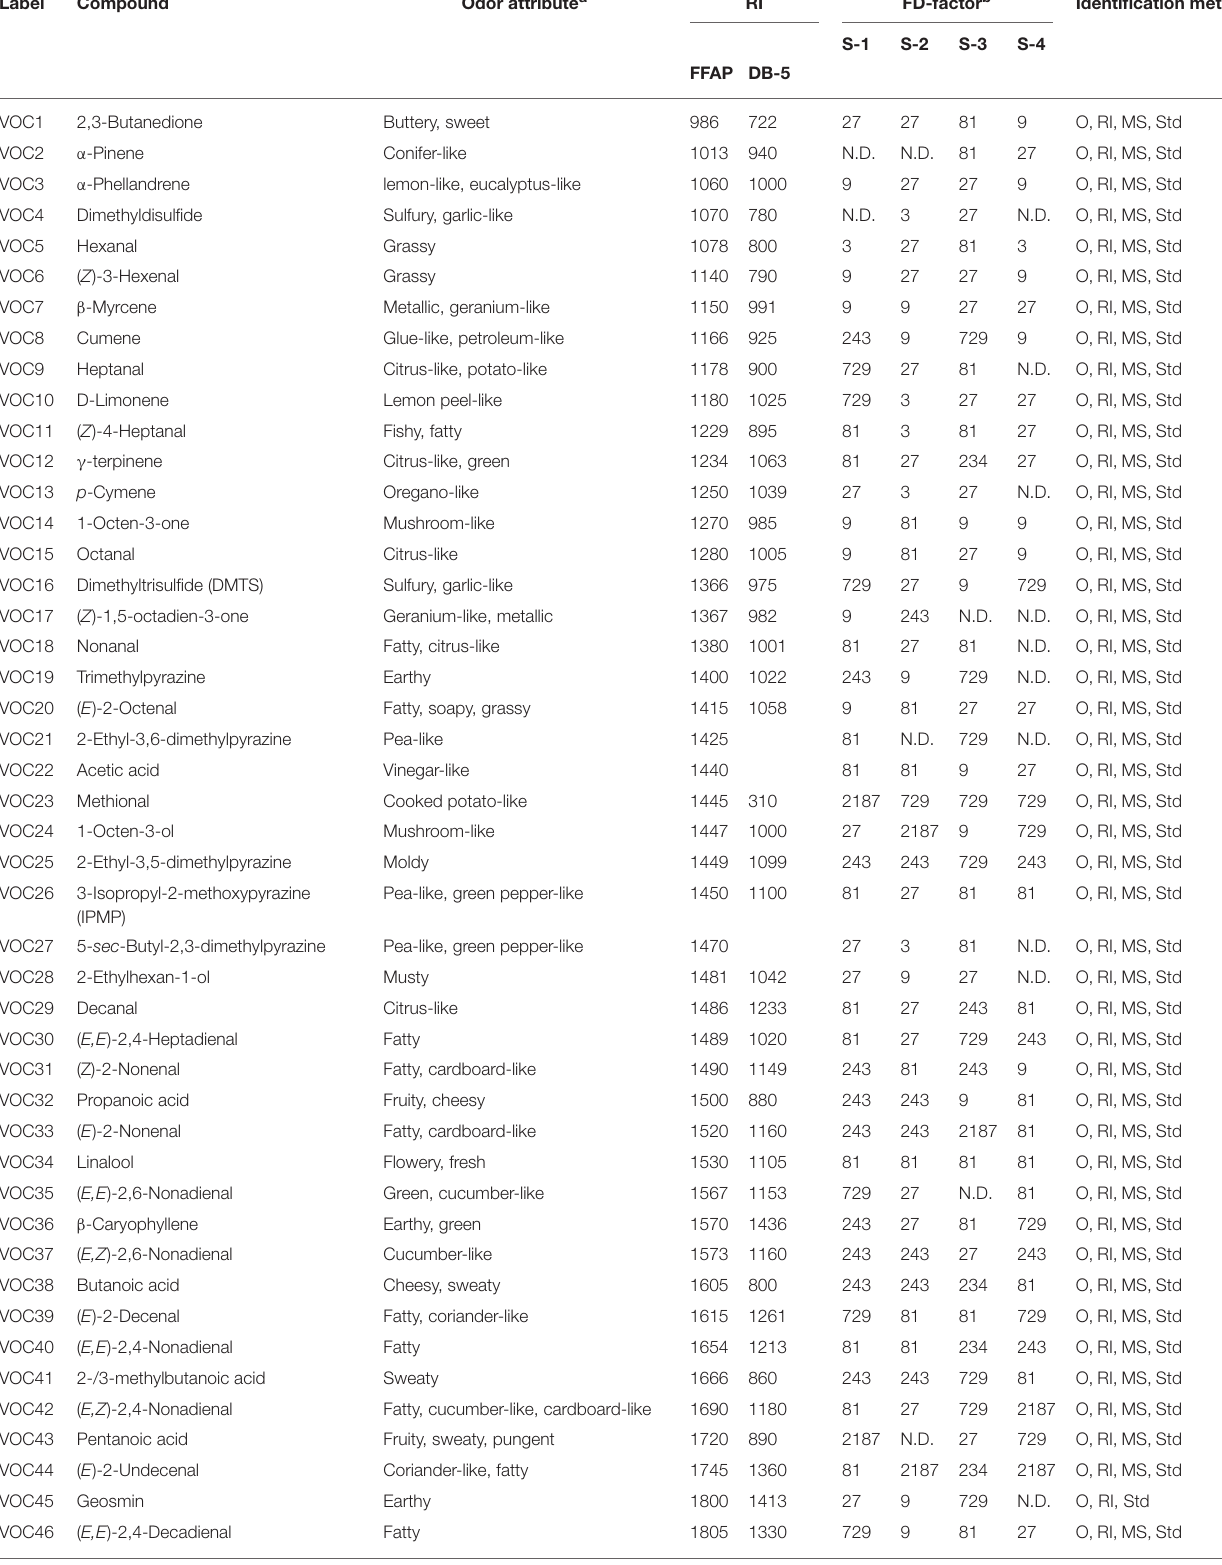
TABLE 1 | Potent aroma compounds identified by GC–O/MS.